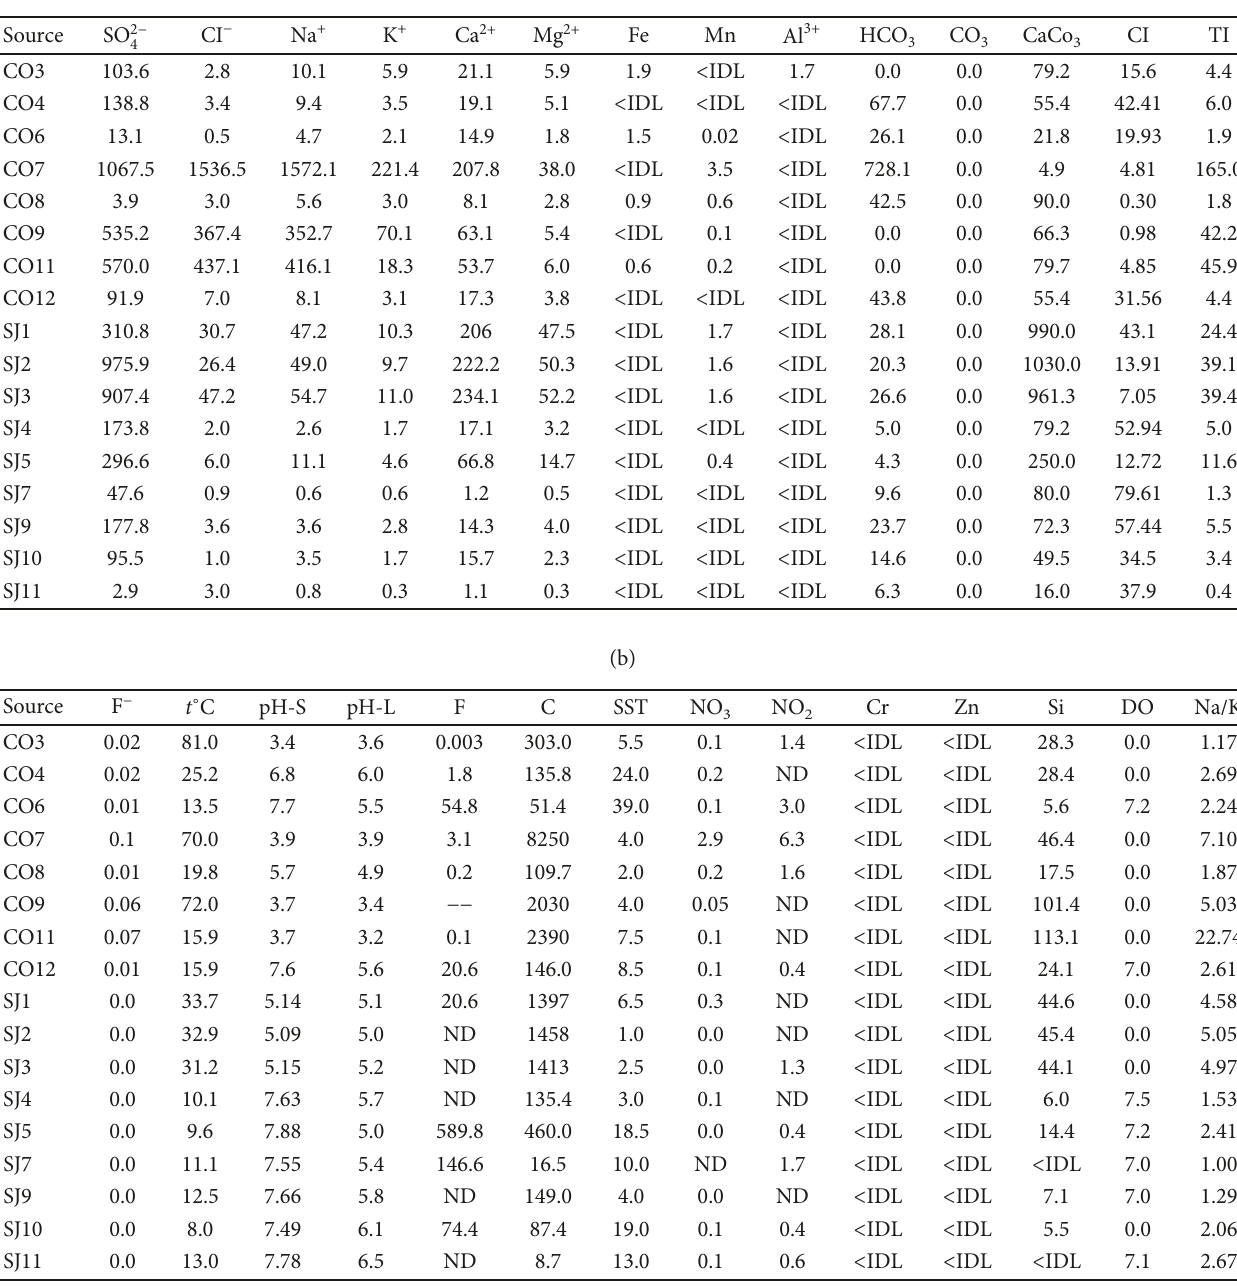
Table 3: Major element concentrations of the geothermal waters from the Coconuco and San Juan sectors, Cauca, Colombia. CI Source SO 2 − 4